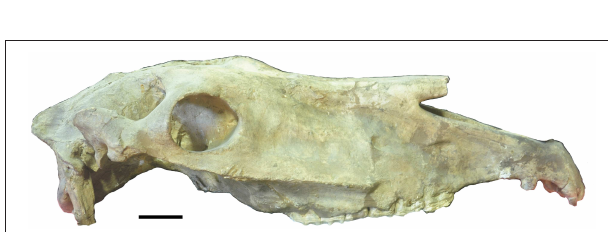
FIGURE 4 | Right lateral view of lectotype skull of E. sanmeniensis , NIH 002, collected from Nihewan Basin.